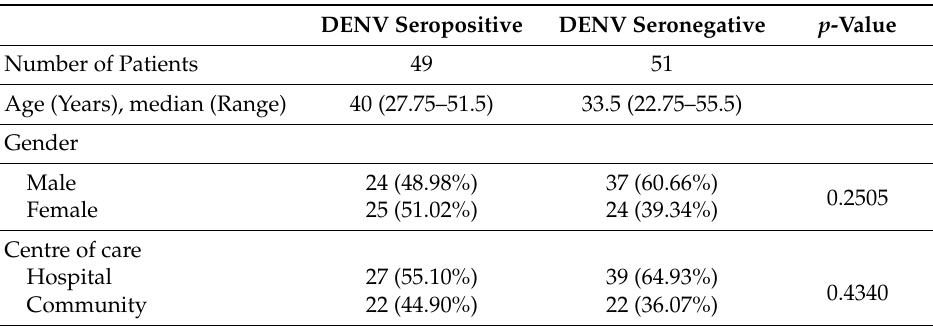
Table 3. Demographic characteristics of the study cohort of DENV-seropositive ( n = 49) and DENV-seronegative ( n = 51)